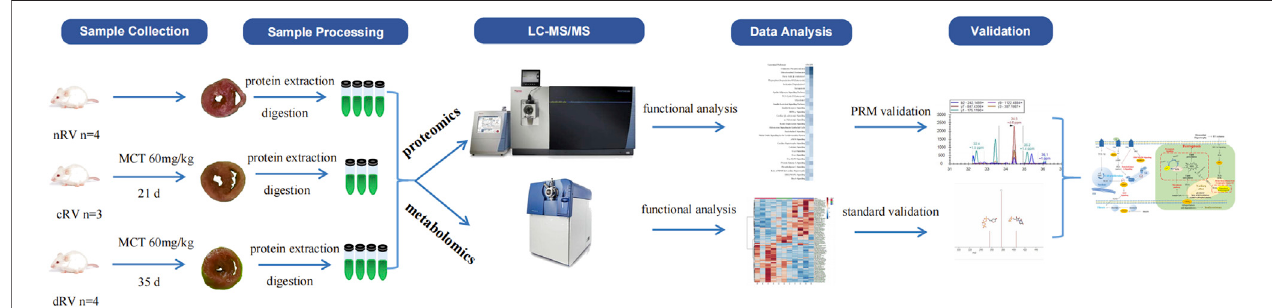
FIGURE1| Aschematicwork fl owoftheproteomicandmetabolomicanalysisofthemyocardiuminthemonocrotaline(MCT)-induced ratmodelofrightventricular failure.